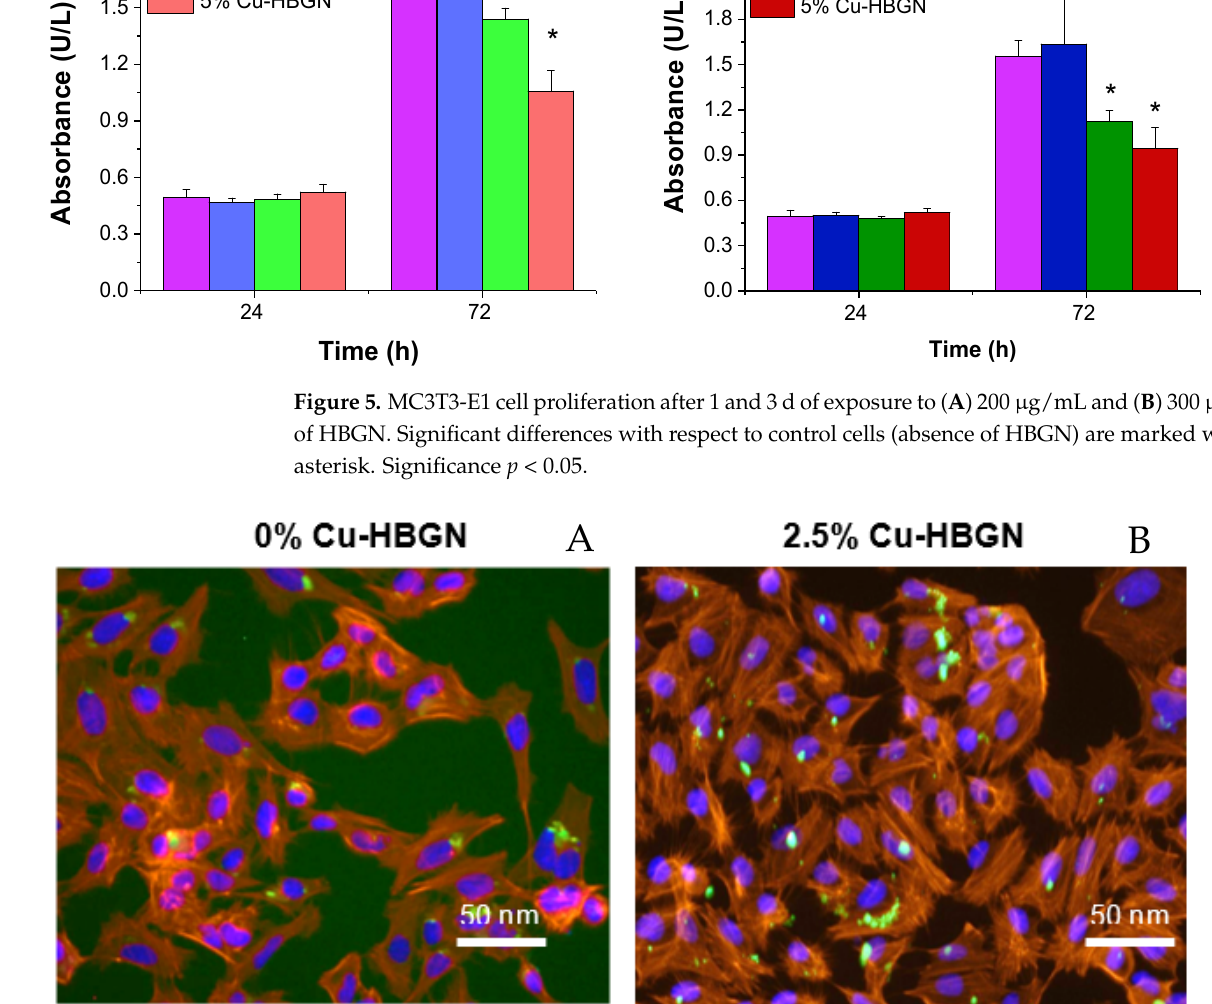
Figure 5. MC3T3-E1 cell proliferation after 1 and 3 d of exposure to ( A ) 200 µg/mL and ( B ) 300 µg/mL of HBGN. Significant differences with respect to control cells (absence of HBGN) are marked with an asterisk. Significance p < 0.05.